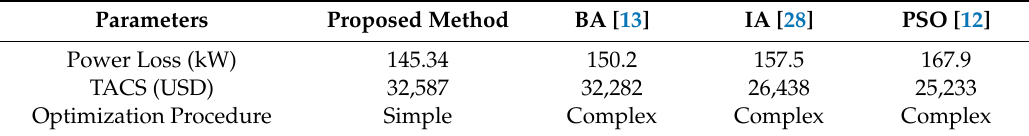
Table 7. Comparative analysis of proposed method with other classical methods for standard - 69 bus Test System.